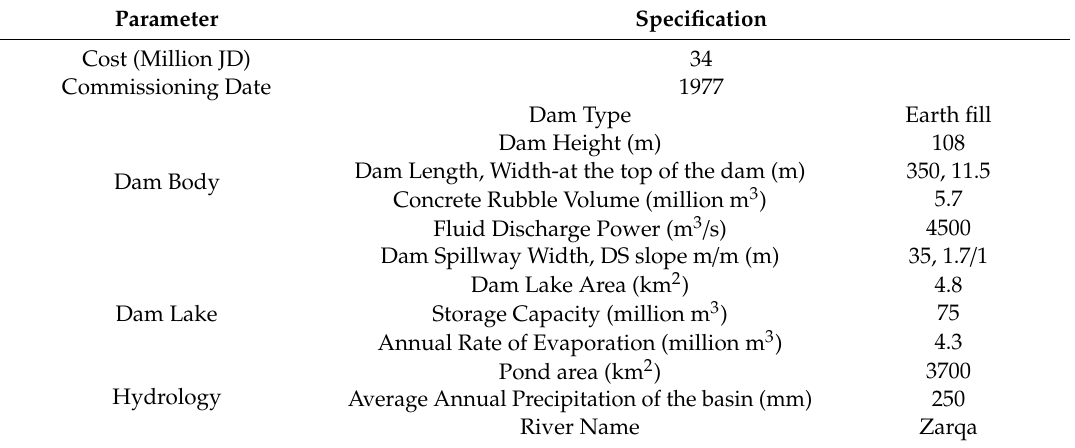
Table 1. King Talal Dam’s Characteristics